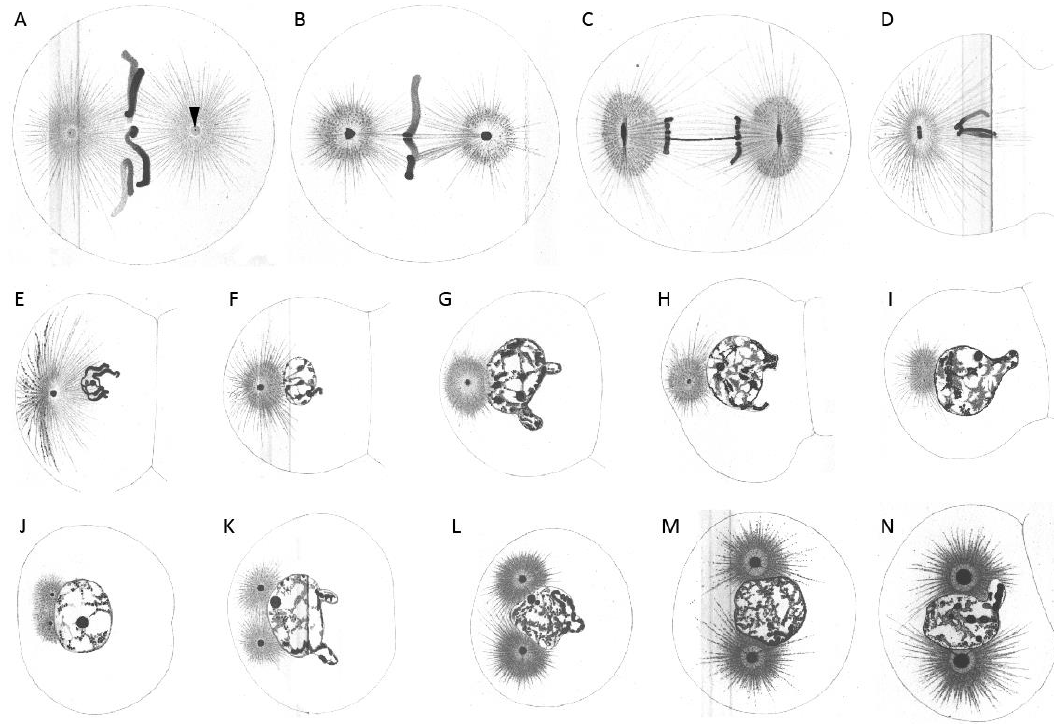
Figure 2. Boveri’s research on the first cleavage in the early embryo of Ascaris megalocephala to demonstrate the centrosome ’cycle’. Embryos were stained with iron haematoxylin. ( A ) Bipolar spindle with spherical centrosomes. Within the centrosomes, centrioles were drawn as small black dots (arrowhead). ( B ) Arrangement of chromosomes at the metaphase plate. ( C ) Separation of chromosomes and change in the shape of centrosomes from spherical to biconvex-discoidal. ( D ) Constriction between forming daughter cells, start of centrosome flattening. ( E – H ) Primary blastomeres. Centrosomes become spherical again ( E ), but smaller compared to the one-cell embryo. The nuclear vesicle is forming and the centrosome starts to divide again ( F , G ). ( I ) Separated centrosomes remain close to each other with the two asters clearly visible. ( J , K ) Daughter centrosomes move apart while growing in size. ( L ) The growing spherical centrosomes are completely separated. ( M , N ) Centrosomes move to opposite sides of the nucleus until they form a bipolar second spindle with full-sized centrosomes. The centrosomes show a ‘core’ and an outer layer. Reproduced from [2].